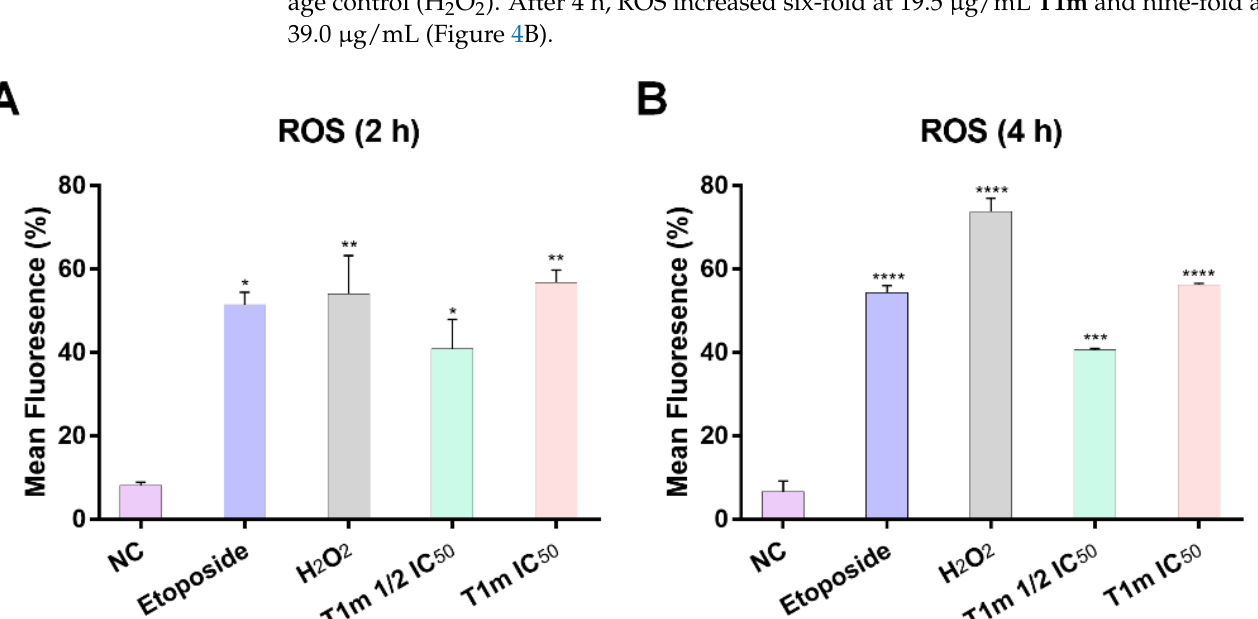
Figure 4. T1m increases ROS levels in the K562 cell line. T1m was evaluated at two concentrations and exposed for 2 h ( A ) and 4 h ( B ). The results represent the mean ± SEM of at least three inde- pendent experiments. Statistical significance was identified with a one-way analysis of variance (ANOVA) followed by a Dunnett’s post -hoc test. Significance was set at * p < 0.05, ** p < 0.01, *** p < 0.001, and **** p < 0.0001 vs. negative control (NC).